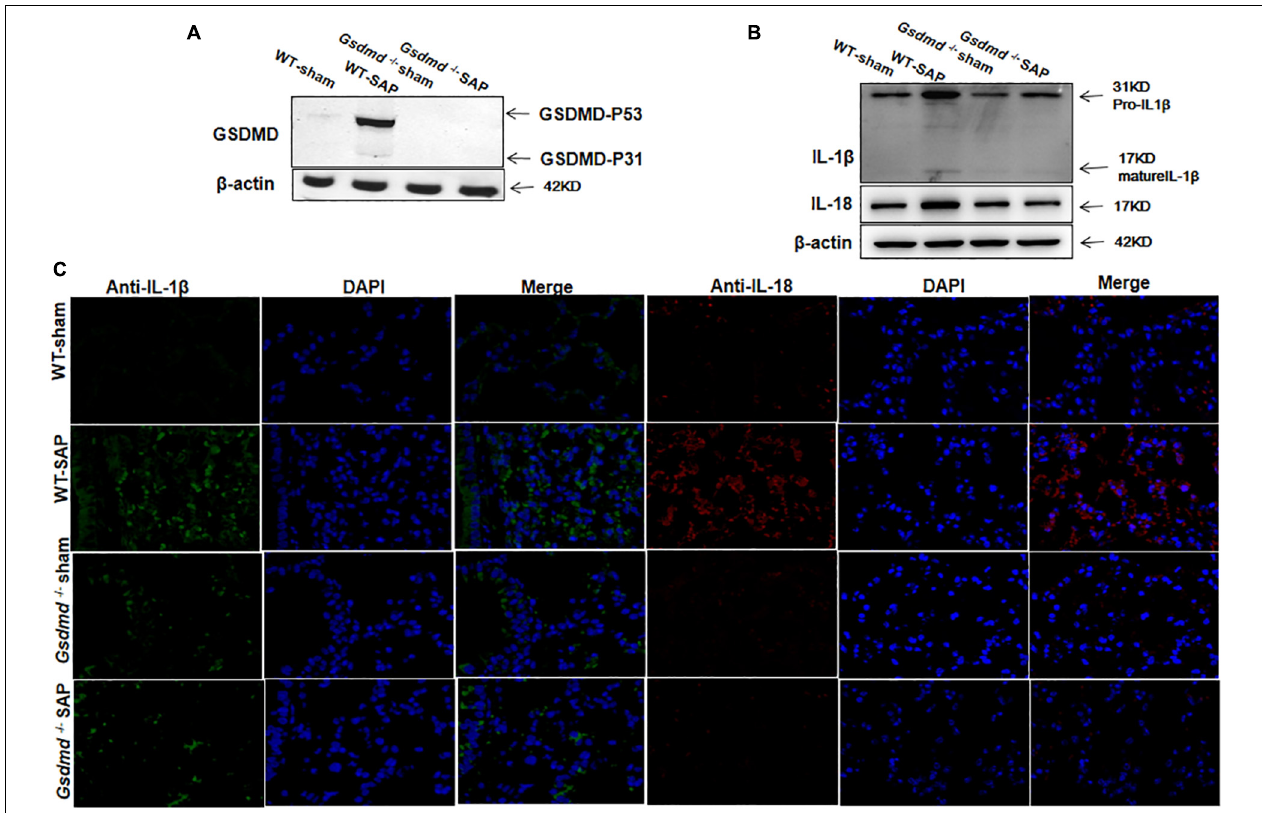
FIGURE 2 | GSDMD-mediated pyroptosis is activated in lung tissues in severe acute pancreatitis mouse models. Mice were sacrificed 24 h after LPS injection, and samples were collected. (A,B) The pyroptosis-associated molecules GSDMD, IL-1 β , and IL-18 were analyzed in the lung by Western blotting. Experiments were repeated three times. (C) Immunofluorescence labeling of IL-1 β (green), IL-18 (red), and DAPI (blue) in the four groups, Scale bar, × 200. All the data are expressed as mean ± SD, n = 10 per WT group, n = 8 per Gsdmd − / − group. GSDMD, gasdermin D; LPS, lipopolysaccharide; WT, wild